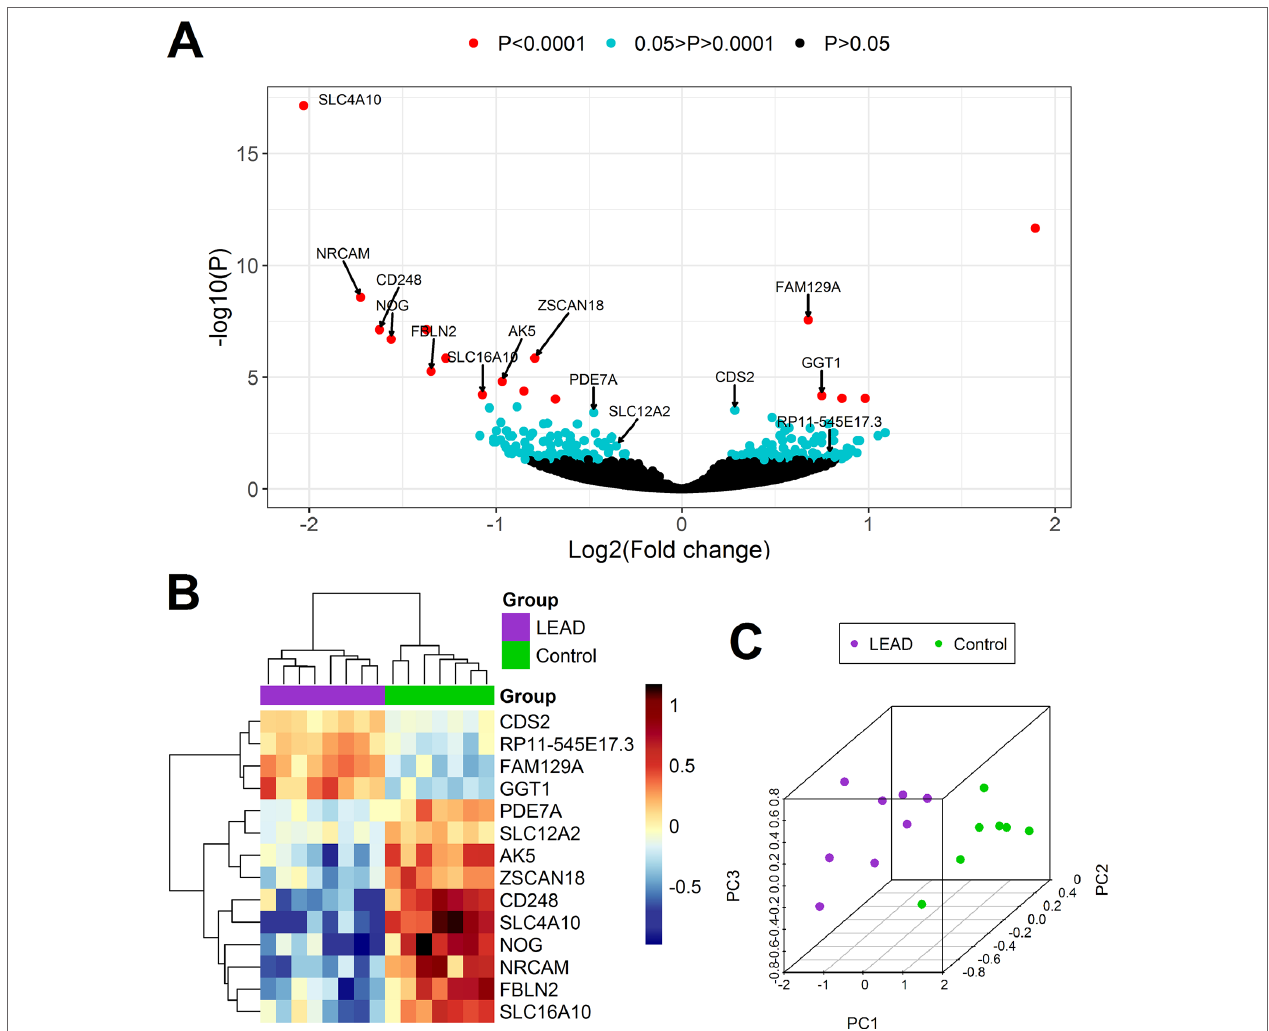
FigURE 3 | Differential expression analysis of genes in PBMCs samples derived from 8 patients with LEAD (LEAD) and 7 non-LEAD controls (Control). Volcano plot (A) illustrating the arrangement of negative log10 of P values and log2 fold changes for 17,868 differentially expressed genes obtained from DESeq2 analysis. Heatmap with Euclidean clustering (B) and 3D PCA plot (c) were generated based on expression of 14 genes determined as indicative for LEAD by both DESeq2 and UVE-PLS